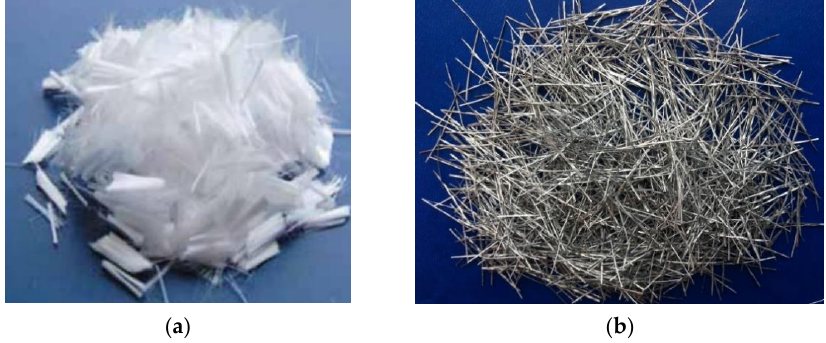
Figure 2. Appearance of the fibers: ( a ) polypropylene; and ( b ) steel. Table 1. Mix proportions.